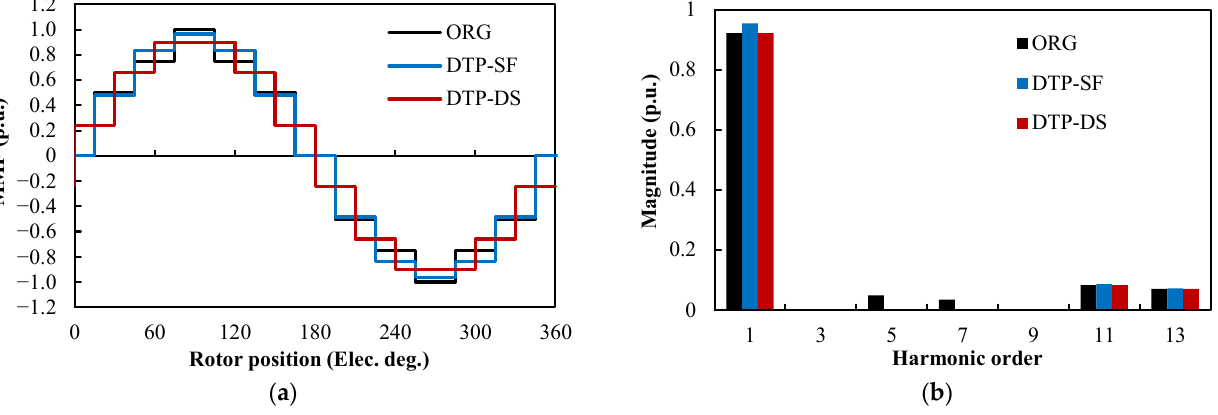
Figure 10. Ideal stator MMF distributions for different winding configurations: ( a ) waveforms; ( b ) spectra.